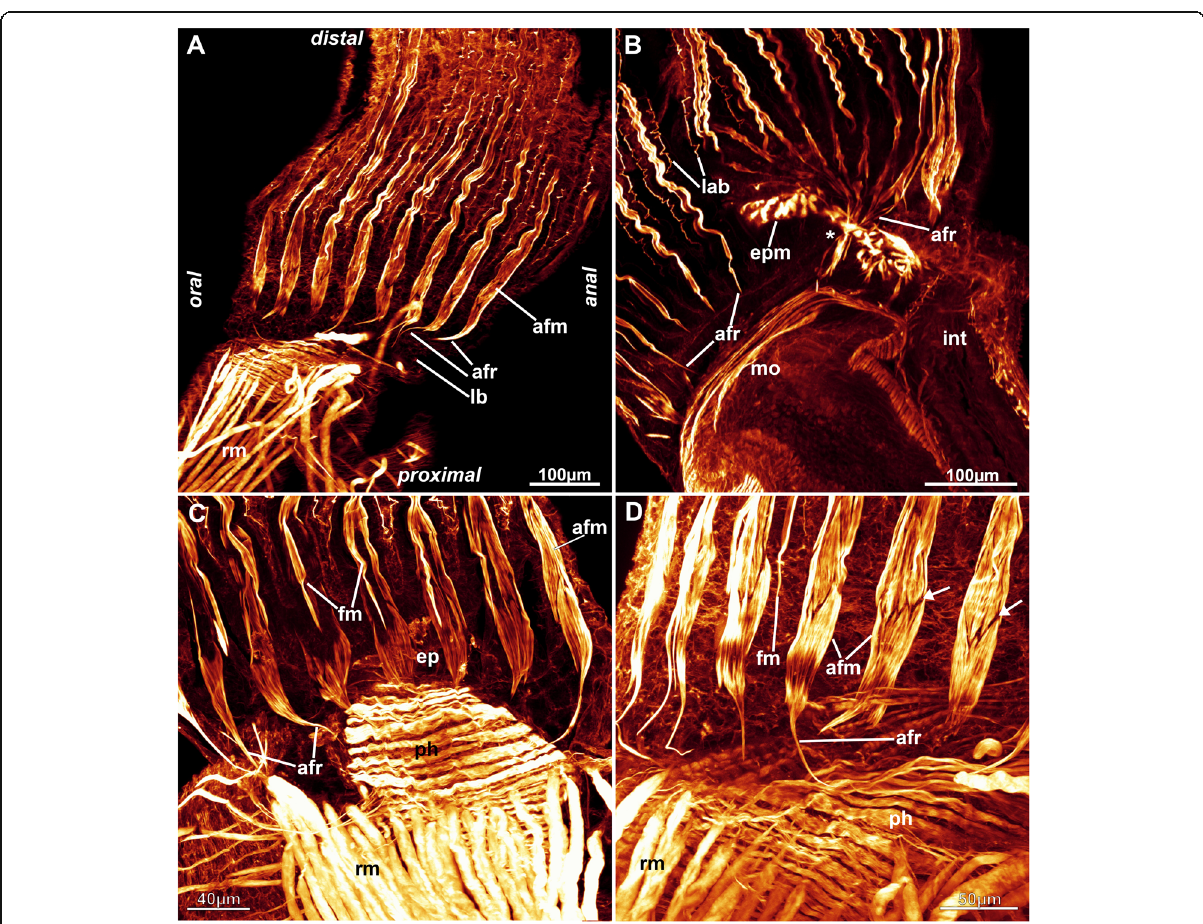
Fig. 15 Muscular system of the lophophore of Stephanella hina . Confocal laser scanning microscopy stacks based on f-actin labelling. Volume renderings, projections or optical slices. F-actin in glow LUT. a Lateral view of a retracted polypide showing the foregut and retractor muscle. b Lateral view of the abfrontal muscle roots in the inner lophophoral concavity where the roots merge lateral to the epistome (asterisk). c Close up from the anal side showing tentacle muscles. d Details of the proximal abfrontal muscle roots. Note the zig-zag arrangement of the abfrontal muscle bands (arrows). Abbreviations: afm – abfrontal muscle band, afr – abfrontal muscle root, ep – epistome, epm – epistome musculature, fm – frontal muscle, int – intestine, lab – lateral actin-rich borders of tentacles, lb. – lophophore base, mo – mouth opening, ph – pharynx, rm.